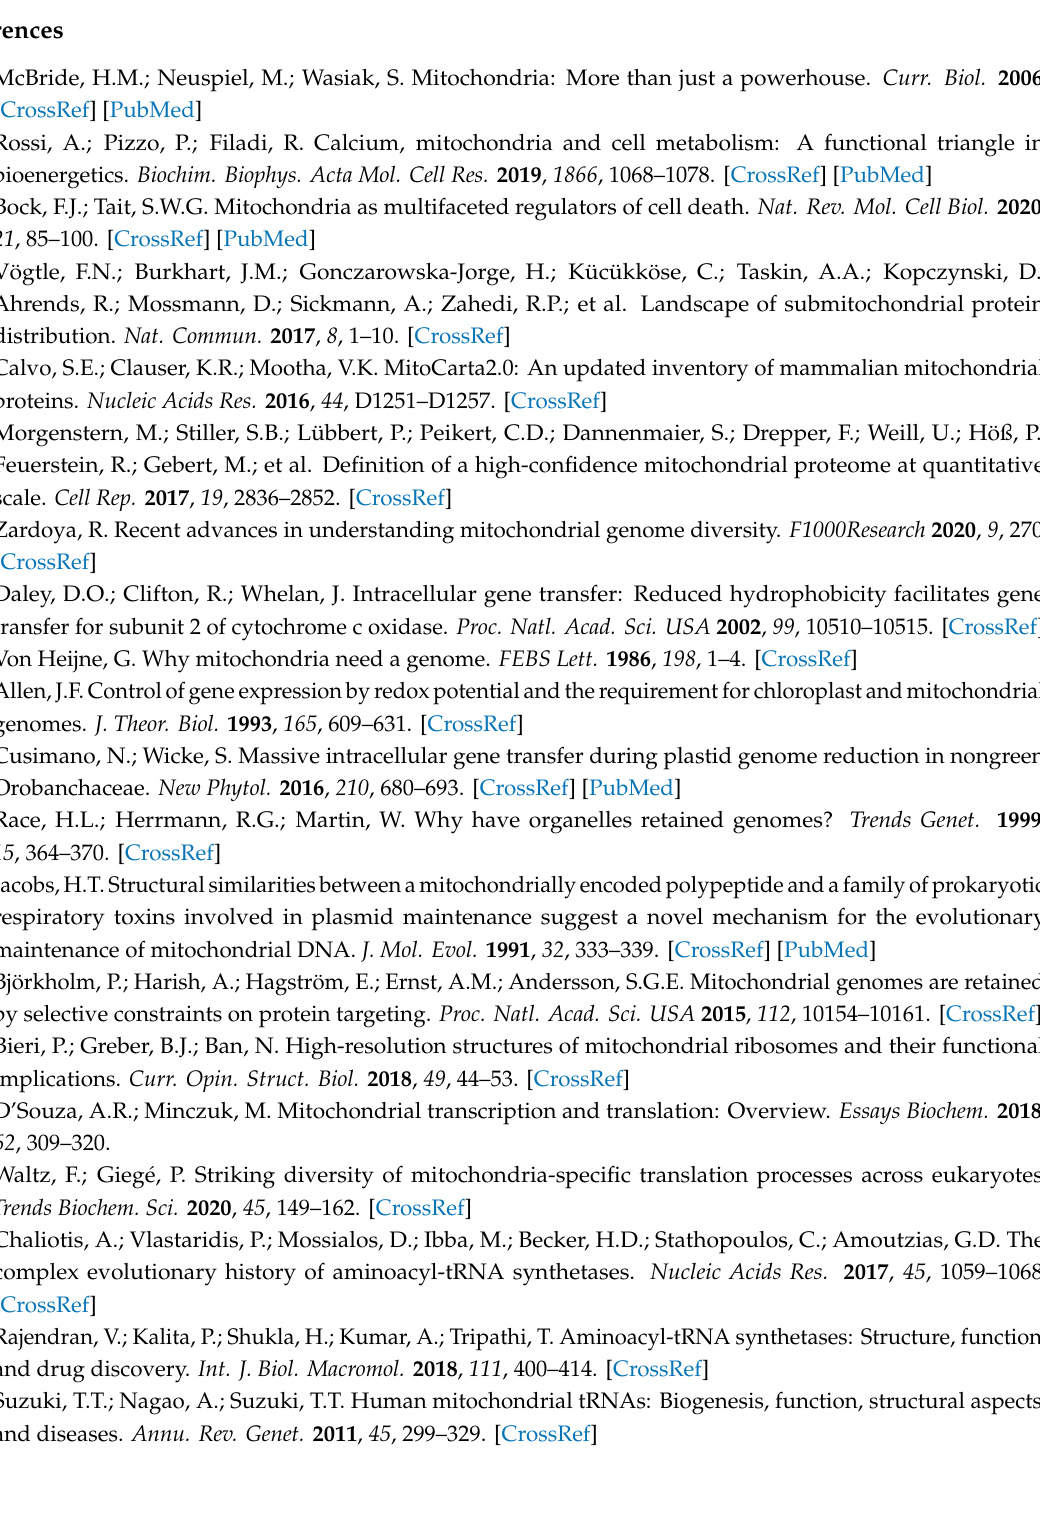
Figure S1: Large version of Figure 2